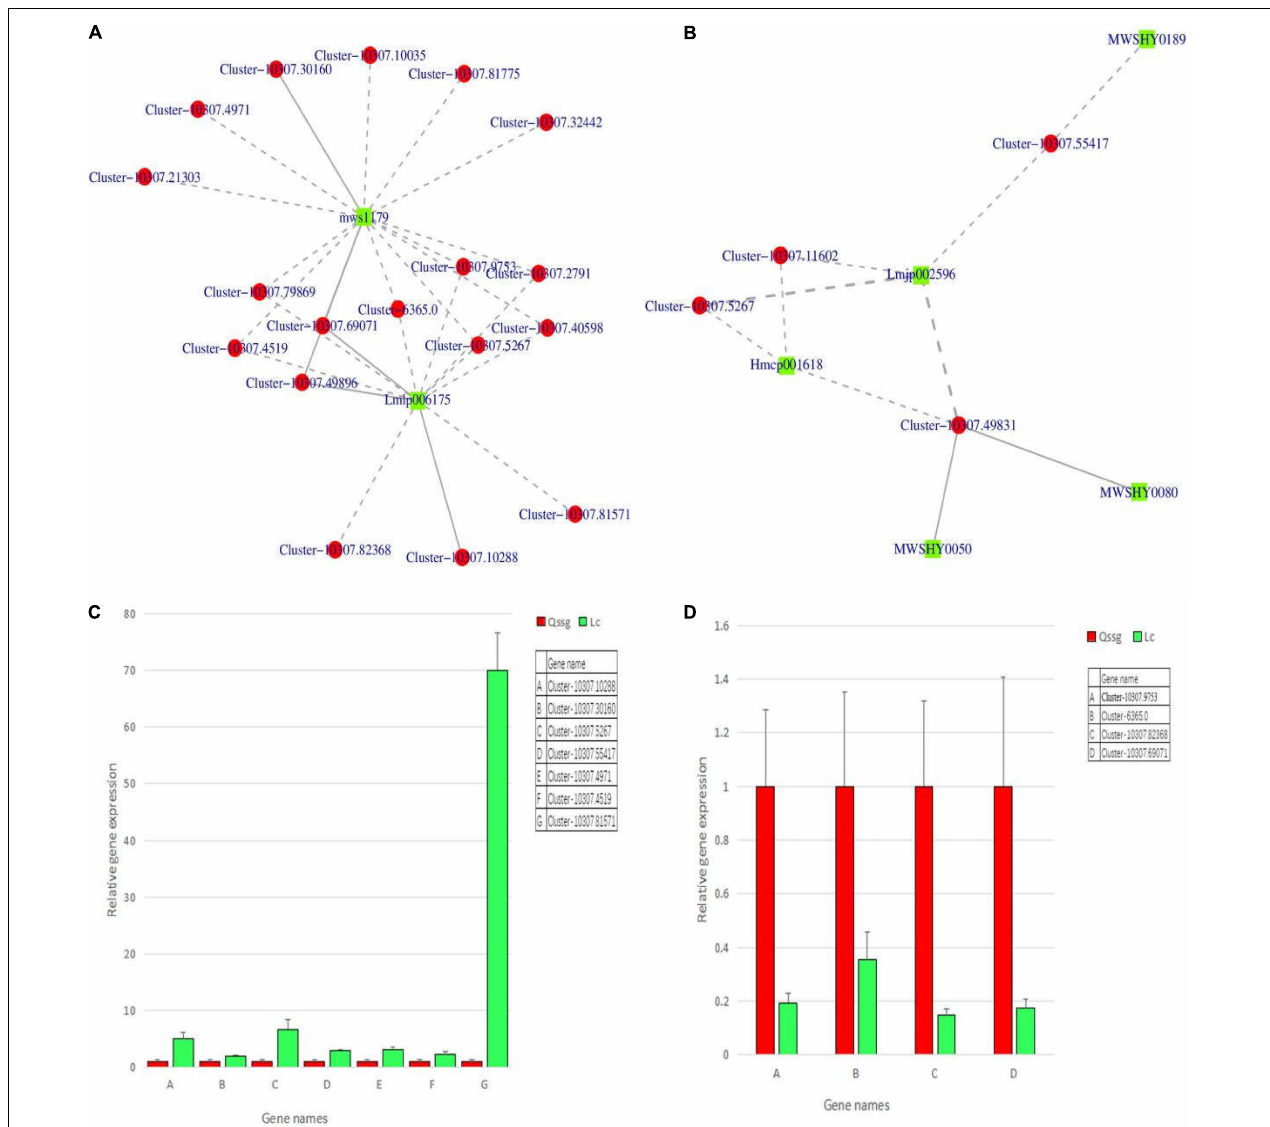
FIGURE 13 | The differential flavonoid-related regulatory gene network in Qssg and Lc Actinidia arguta Sieb.Zucc. fruits and qRT-PCR confirmation map. (A,B) Twenty-one structural genes and 7 flavonoids showed higher correlation coefficient values ( r > 0.8). (C) The relative expression of seven structural genes in Lc was higher than that in Qssg. (D) The relative expression of four structural genes in Lc was lower than that in Qssg. Most of the selected genes showed high correlation between the qPCR and RNA-Seq datasets, thus validating the transcriptome data (2 − (cid:49)(cid:49) Ct value of the internal reference gene is